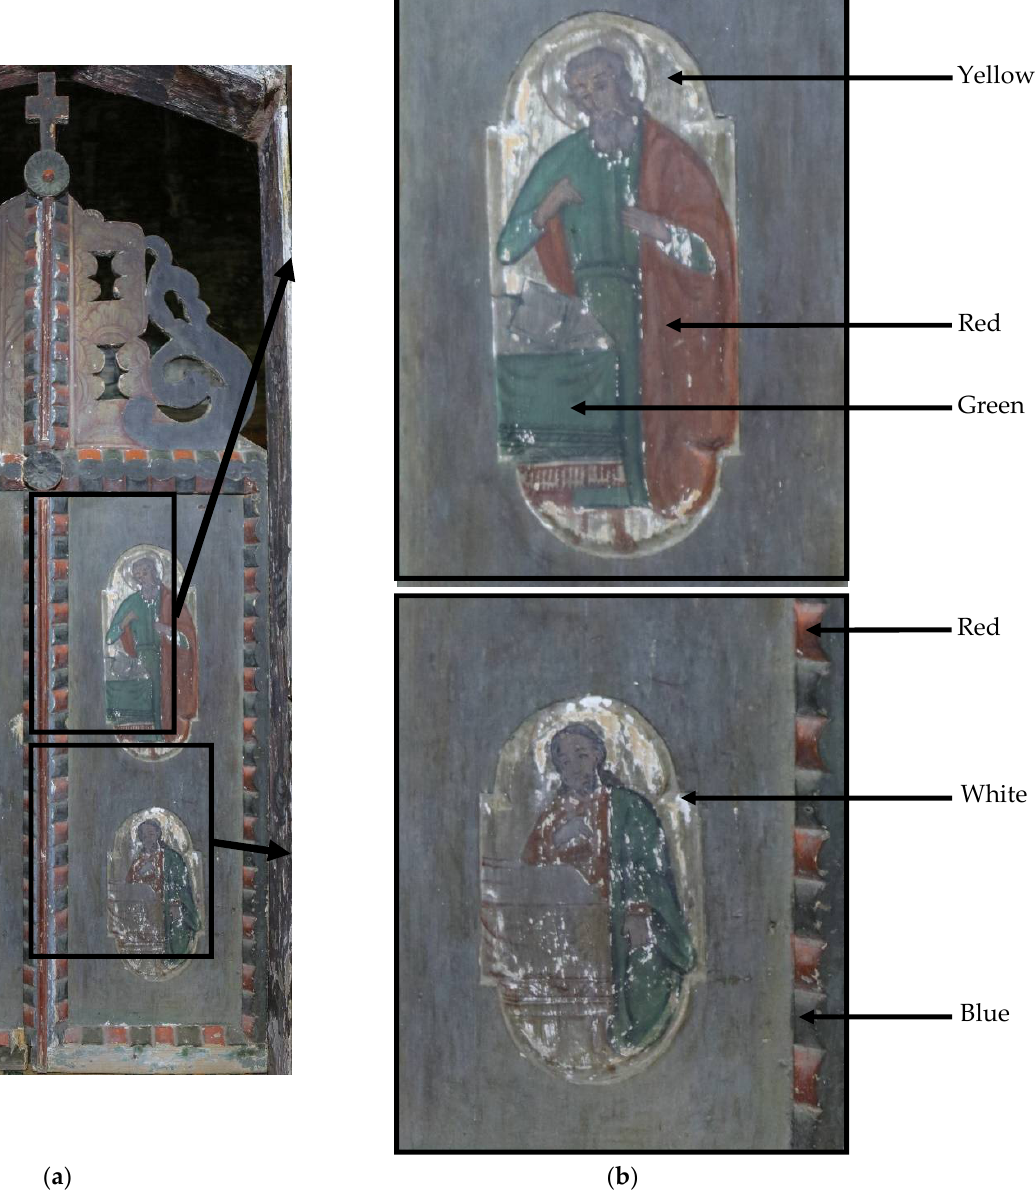
Figure 2. The Imperial Gates of Voivodeni wooden church ( a ) and the indication of the sampling points ( b ).